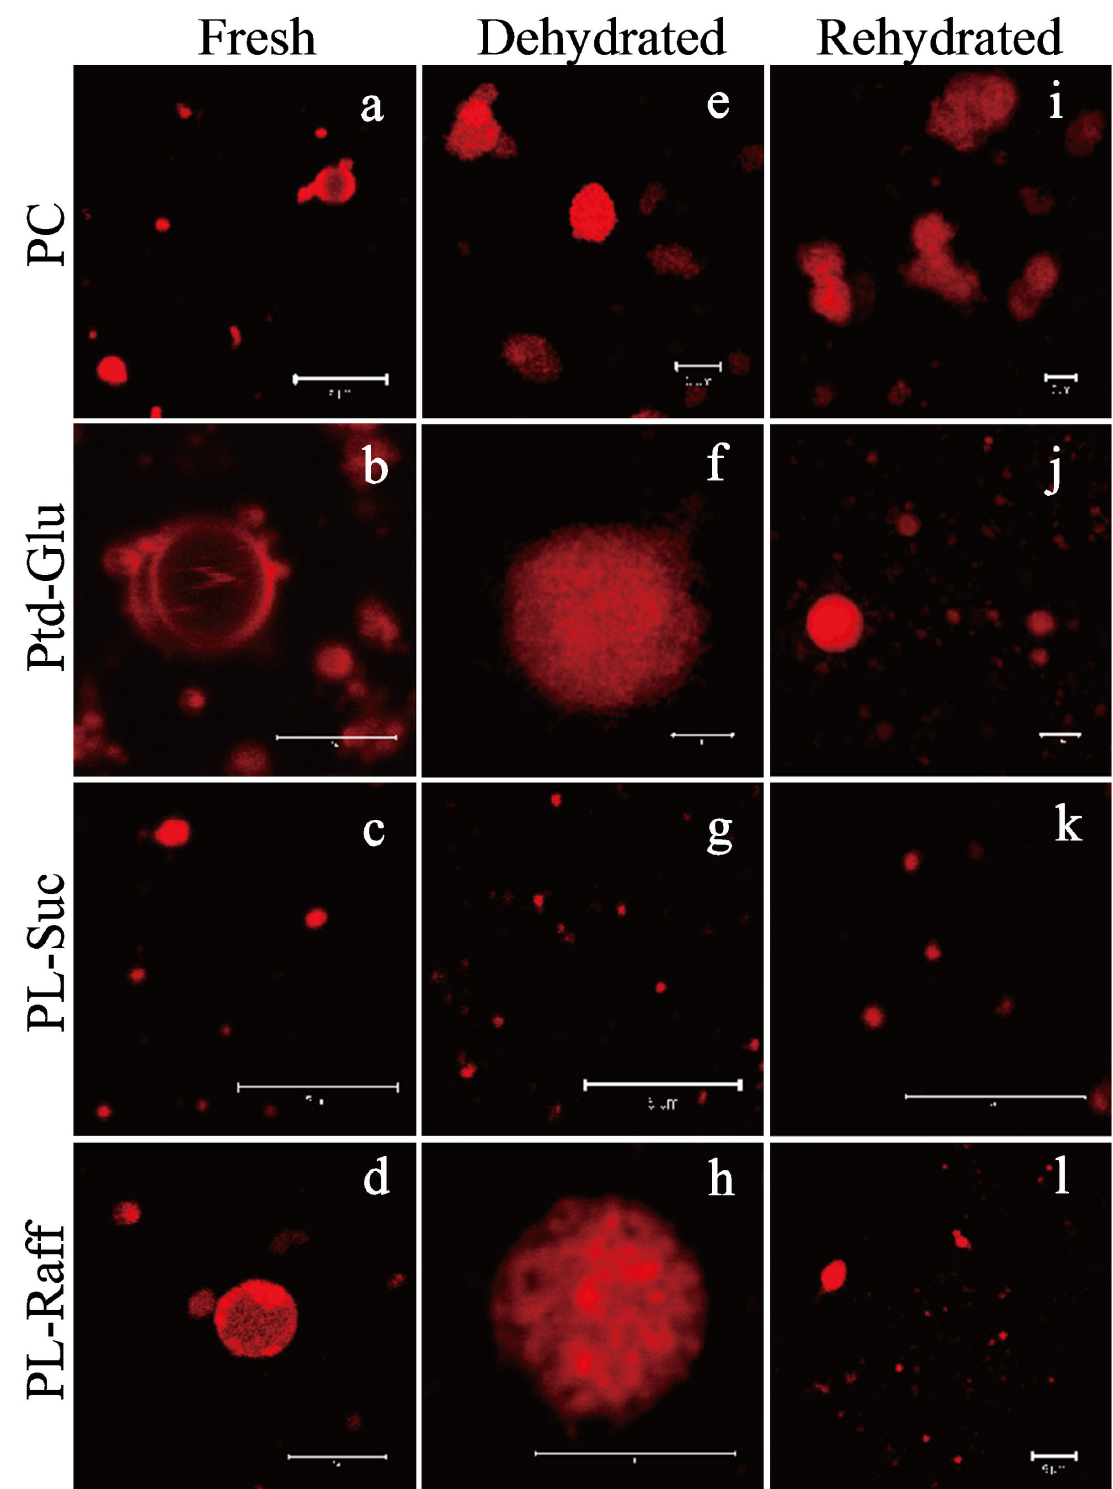
Figure 6. CLSM images of nanoliposomes following dehydration and rehydration procedure (size bar: 5 µm). (a-d) Morphology of freshly prepared nanoliposomes (e-h) Morphology of nanoliposomes following dehydration procedure (i-l) Morphology of nanoliposomes following rehydration procedure. doi: 10.1371/journal.pone.0073891.g006 PLOS ONE |